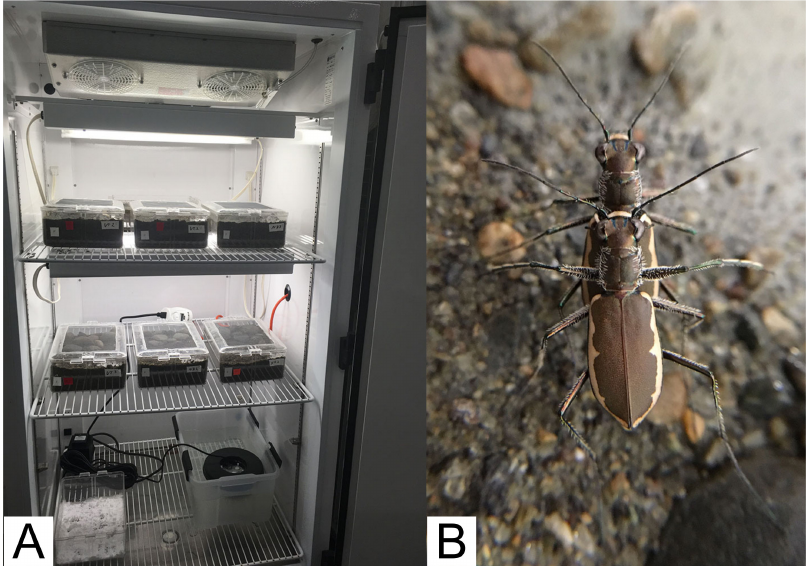
Figure 2. ( A ) shows the rearing bins arranged in the environmental chamber used for this study. ( B ) shows an overview of a coupled pair of C. marginipennis also from this study, with the male engaging in mate-guarding behavior, which often occurs after